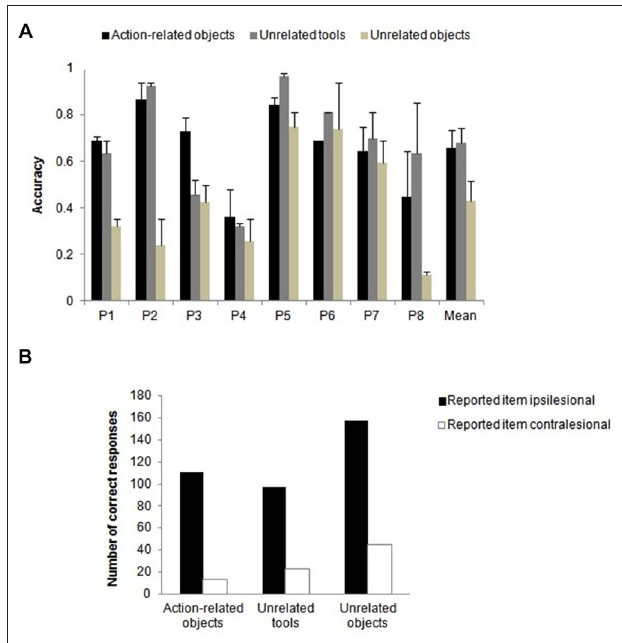
FIGURE 3 | Intact handles only. (A) Mean patient accuracies and (B) number of correct responses for two-item trials when only one item of an object pair was reported (either on the ipsilesional or on the contralesional side) as function of object pair condition when both handles were intact. Error bars denote